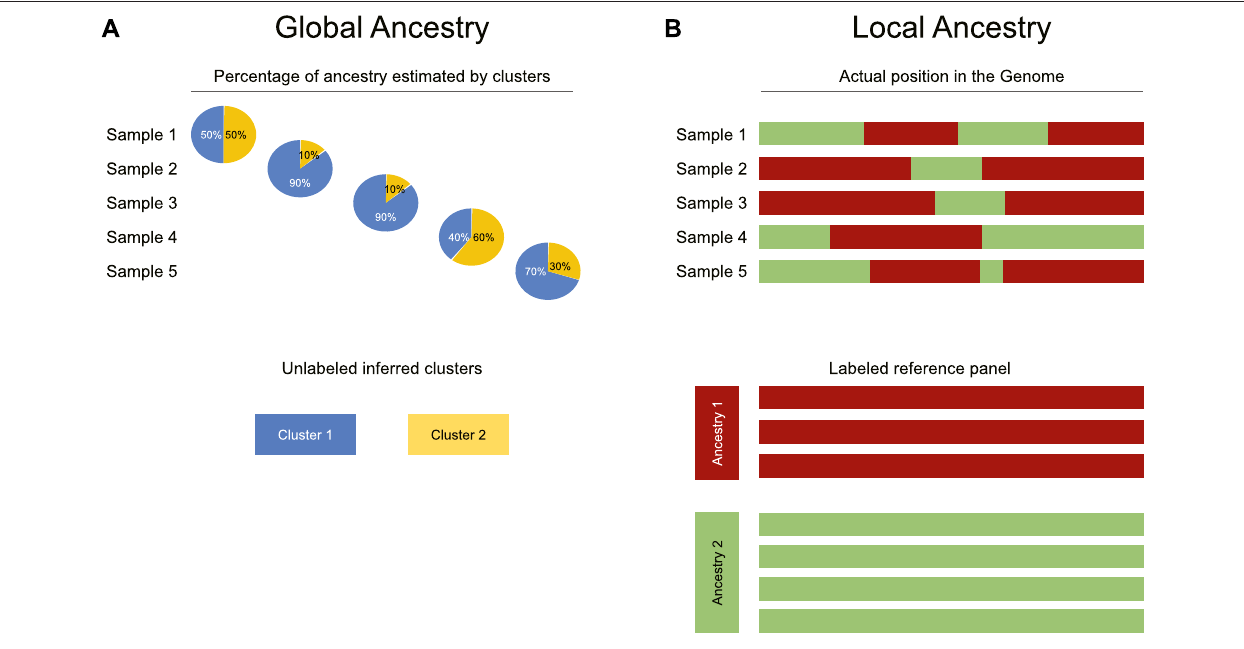
FIGURE2| Differences betweenglobaland localancestryanalysis. (A) Globalancestry analysisinfers theproportion ofeach individual ’ sgenome thatcomes from each ancestral population (represented as clusters identi fi ed in an unsupervised manner). (B) In contrast to global ancestry analysis, local ancestry inference uses a reference panel to attribute each physical segment of the genome to a speci fi c ancestry reported in the panel.